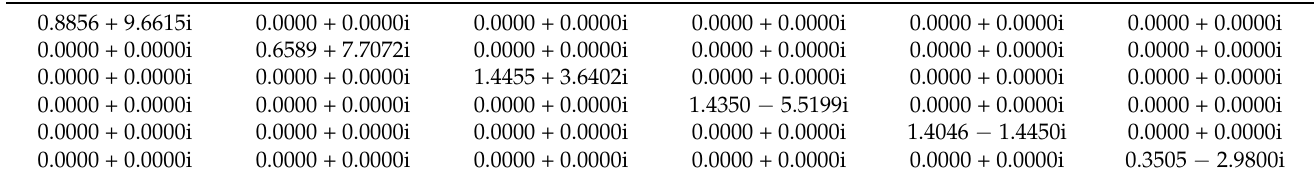
Table 3. Eigenvalues (D = λ ).